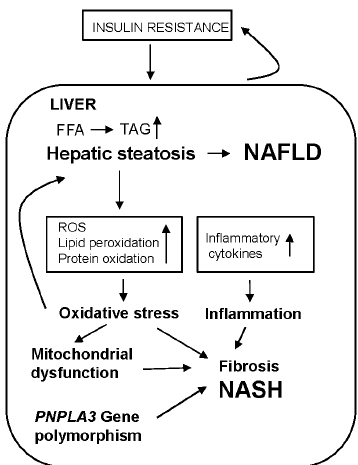
Figure 3. The development and progression of NAFLD. The development of insulin resistance increases the supply of free fatty acids (FFA) to the liver causing increased TAG synthesis and hepatic steatosis. Oxidative stress may also contribute to this process. The steatosis leads to inflammation and increased oxidative stress, which in turn causes mitochondrial dysfunction. These conditions, together with other factors such as PNPLA3 gene polymorphism, result in the development of fibrosis and ultimately NASH. In the traditional 2 hit hypothesis [48] the initial steatosis is the first hit and the second hits are the resulting oxidative stress and inflammation. It is now clear, however, that multiple hits are involved in the